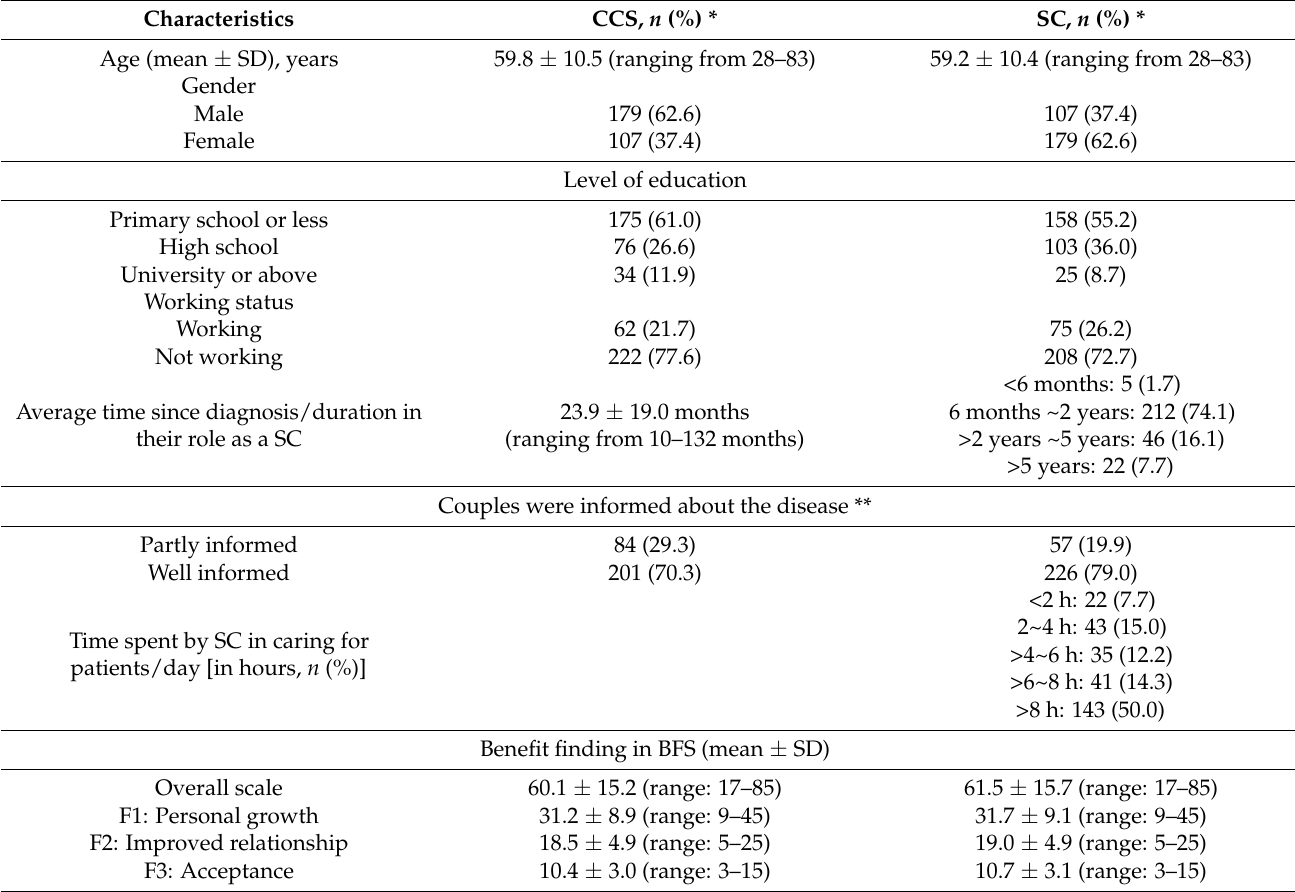
Table 2. Descriptive statistics of colorectal cancer survivors and spousal caregivers ( n = 286).